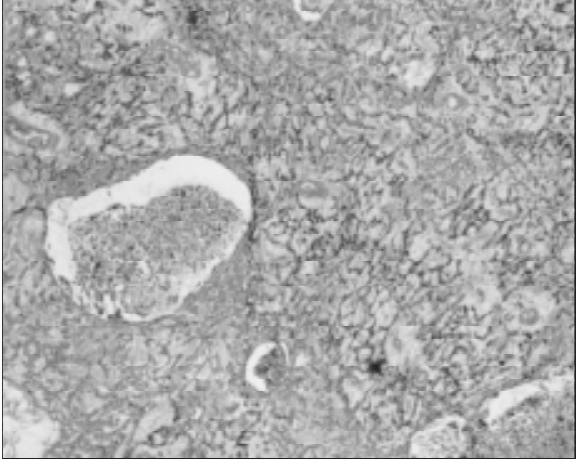
Figura 1 – Neoplasia constituída por cordões anastomosantes e grupos de células neuroepiteliais (H&E 40x)